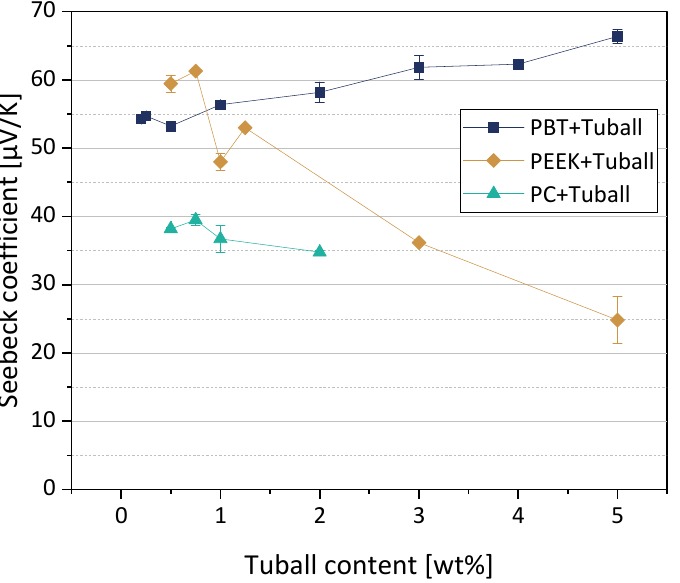
Figure 4. Seebeck coefficients (at 40 °C) of PC, PEEK, and PBT-based composites filled with SWCNT Tuball ™ (values based on Refs. [11,27], newly compiled. Adapted with permission from reference [27]. Copyright 2022 American Chemical Society).